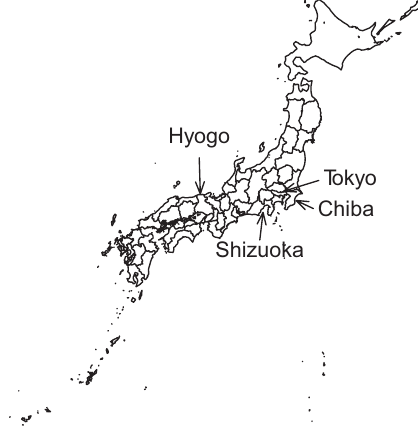
Figure 1. Map of Japan with the regions listed in Table